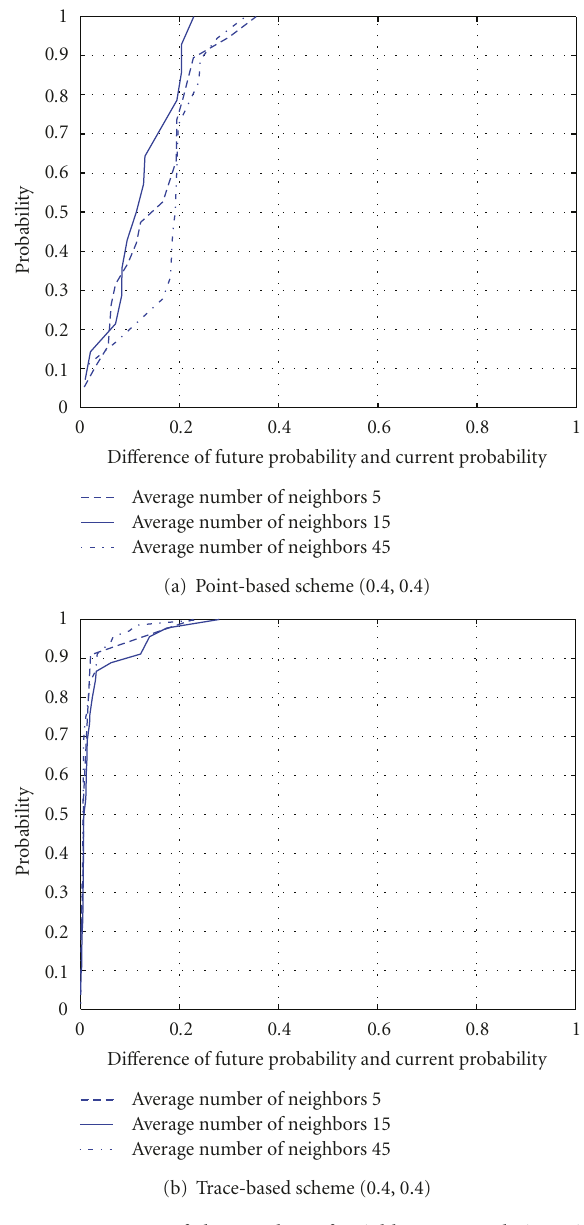
Figure 9: Impact of the number of neighbors: Cumulative Dis- tribution Function (CDF) of the positive di ff erence of the future probability Pr dt to the past probability Pr dt of the near likely node under di ff erent average number of neighbors in walking scenario: 5, 15, and 45.